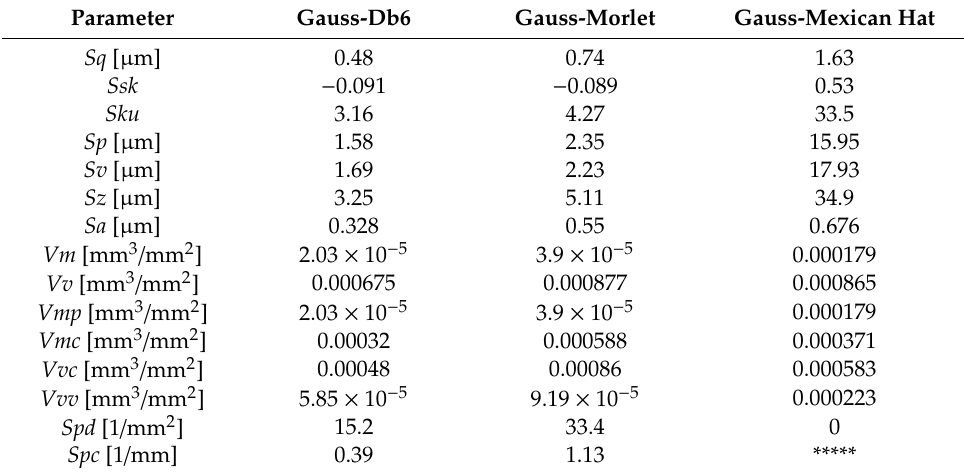
Figure 22. Surfaces of sample no. 4 with flat-top structure, after leveling, shape removing, and applying: ( a ) Gaussian filter, ( b ) Daubechies wavelet, ( c ) Morlet wavelet, ( d ) Mexican hat wavelet. Table 5. Selected spatial parameters calculated for surfaces shown in Figure 23.